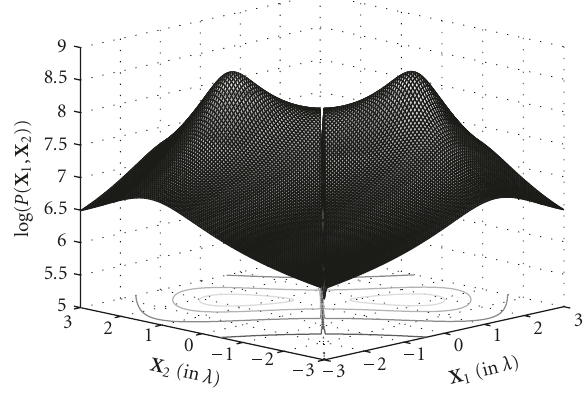
Figure 2: Generalized time-reversal MUSIC pseudospectrum for the multiple scattering case for SNR = 20dB.